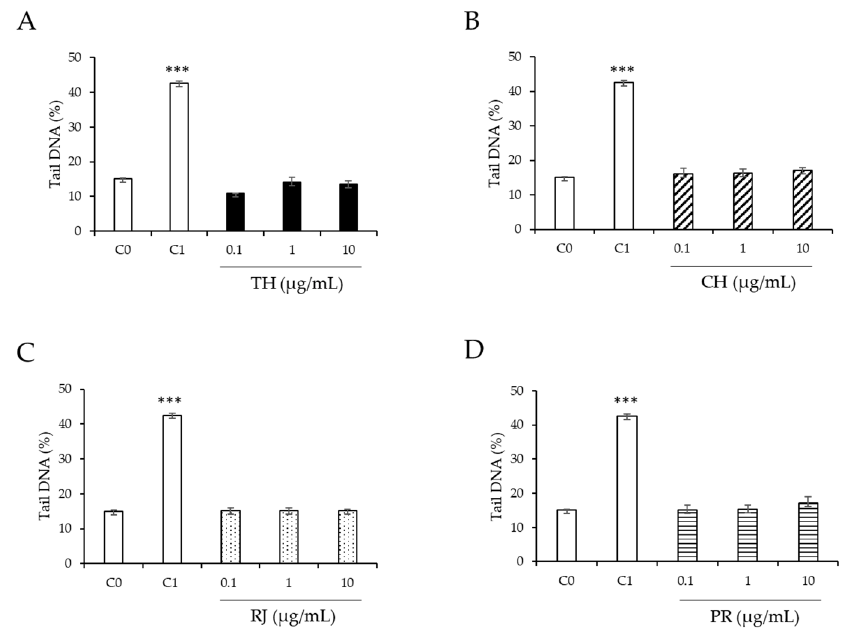
Figure 3. Induction of DNA strand breaks by ( A ), thyme honey (TH, sample 1, ); ( B ), chestnut honey (CH, sample 6, ); ( C ), royal jelly (RJ, sample 15, ); and ( D ), propolis (PR, sample 16, ) at 0.1–10 μ g/mL in human HepG2 cells. C 0 , untreated cells ( ). C 1 , cells treated with BaP (100 μ M, ). Asterisks indicate significant difference from control (C 0 ). *** p ≤ 0.001.